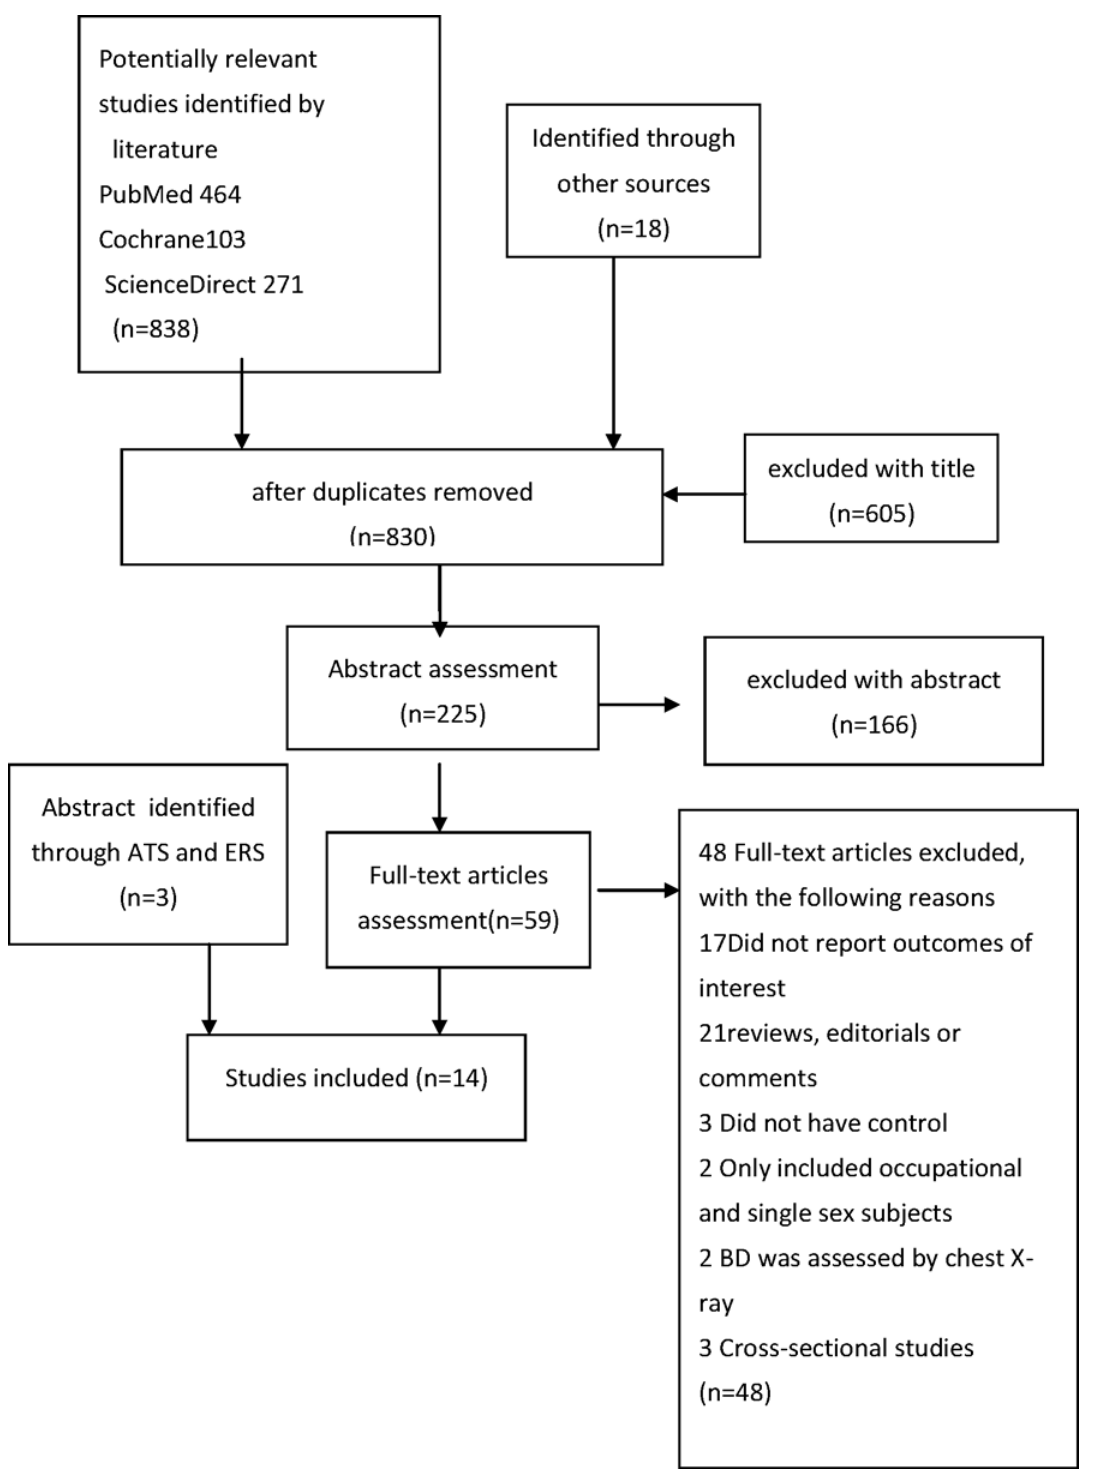
Fig 1. Flowchart of process of literature review and selection.